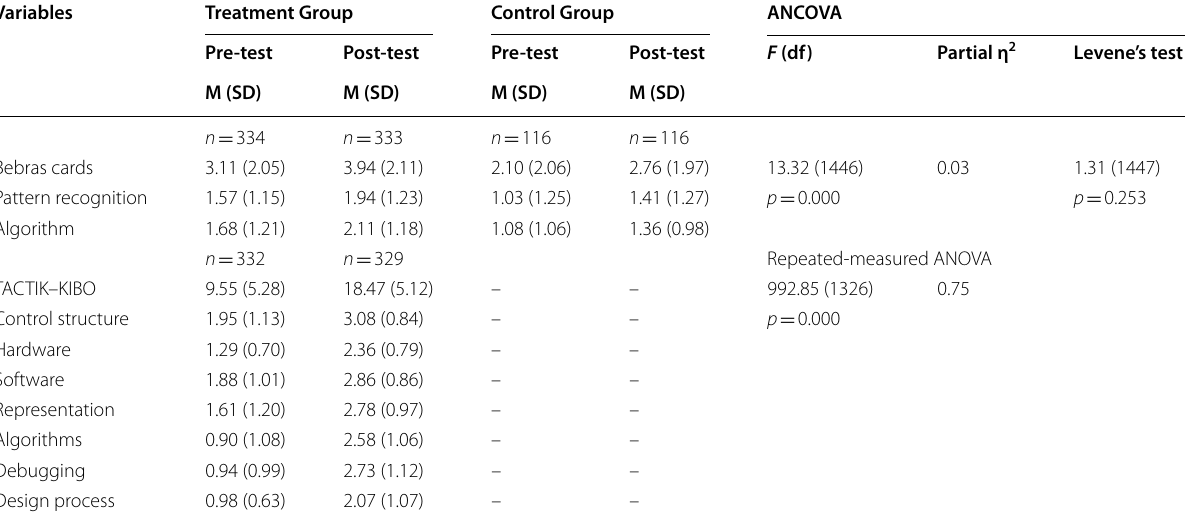
ANCOVA analysis of covariance, ANOVA analysis of